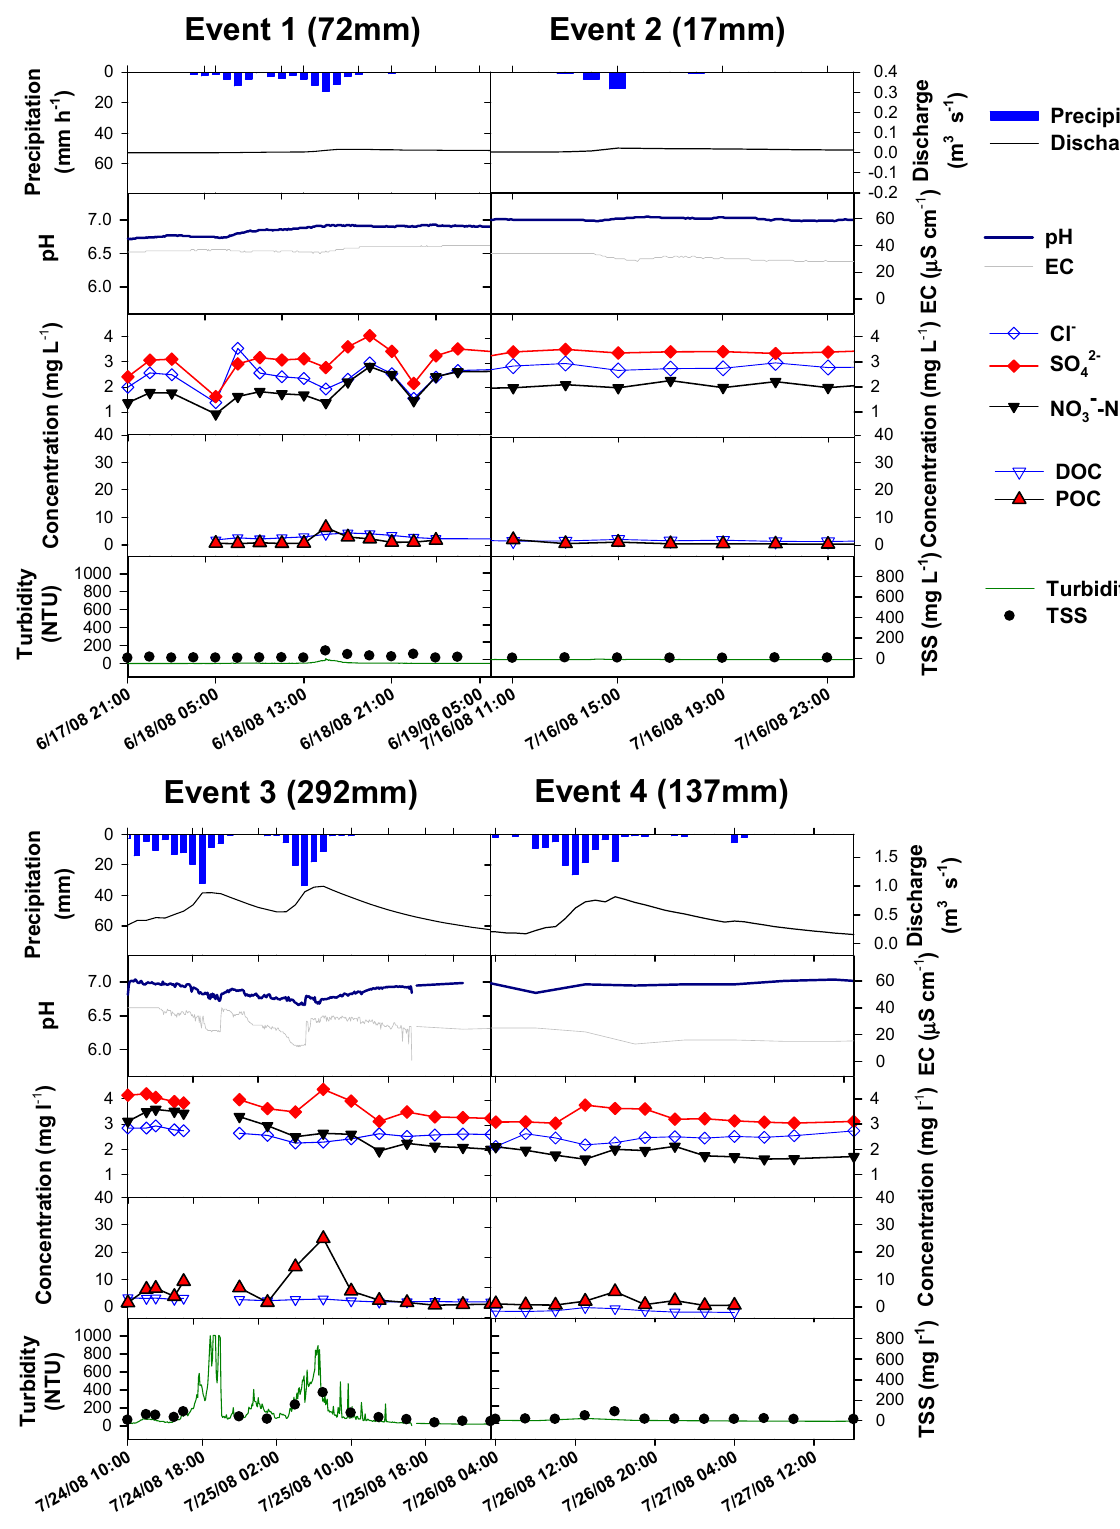
Figure 3. Temporal variations in hourly precipitation (mm), discharge (m 3 ·s − 1 ), pH, EC ( μ S·cm − 1 ), concentrations (mg·L − 1 ) of dissolved ions, DOC, and POC, turbidity (NTU), and TSS concentration (mg·L − 1 ) during four rainfall events in 2008. DOC and POC data of the four storm events have been published in a previous report